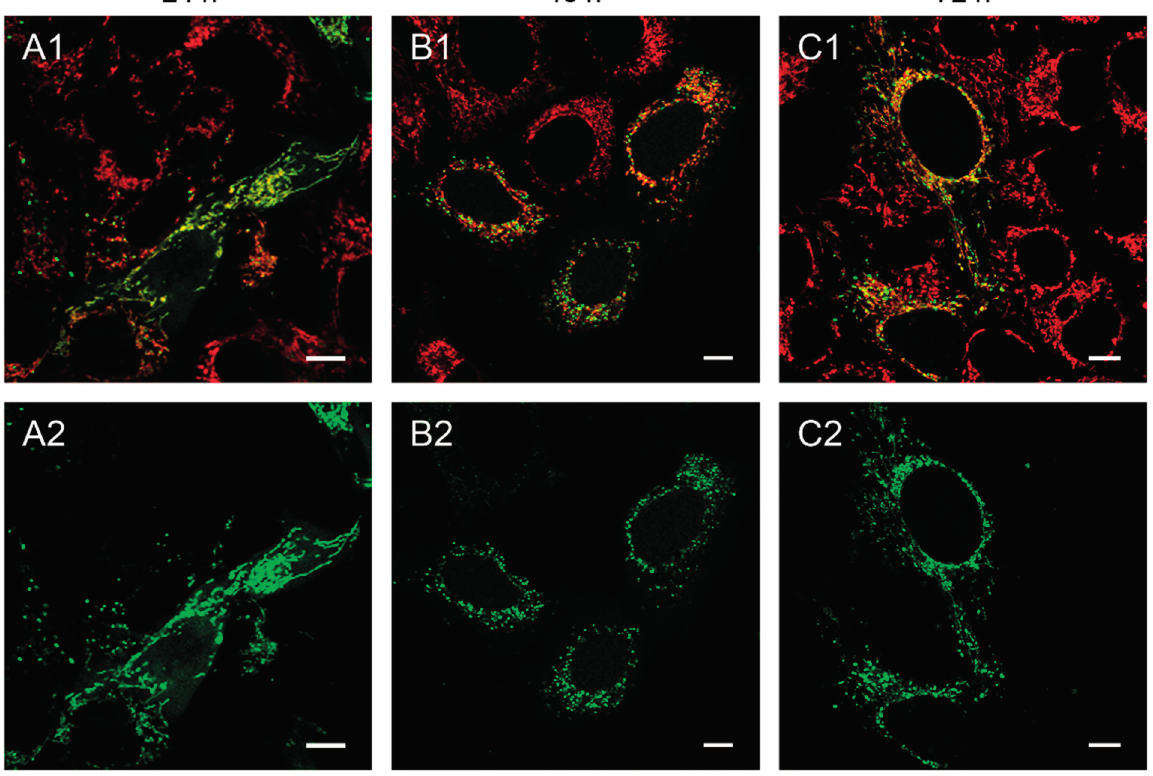
Figure 1. 143B.TK − cells transfected with linear depletion system. 143B.TK − cells were transfected with the linear depletion system (MEE-con-module) and analyzed by confocal laser scanning microscopy. The EGFP-tagged restriction endonuclease (enhanced green fluorescent protein, green color, panels A2 – C2 ) shows a uniform distribution or a punctate appearance (“nucleoid” structure) and co-localizes with the MitoTracker ® Red CMXRos-stained mitochondrial network (red color, panels A1 – C1 ). The superimposition of both colors is depicted in the top panel. Images were collected at intervals of 24 h post-transfection. White arrows show dissolving mitochondrial network. Calibration marks correspond to 10